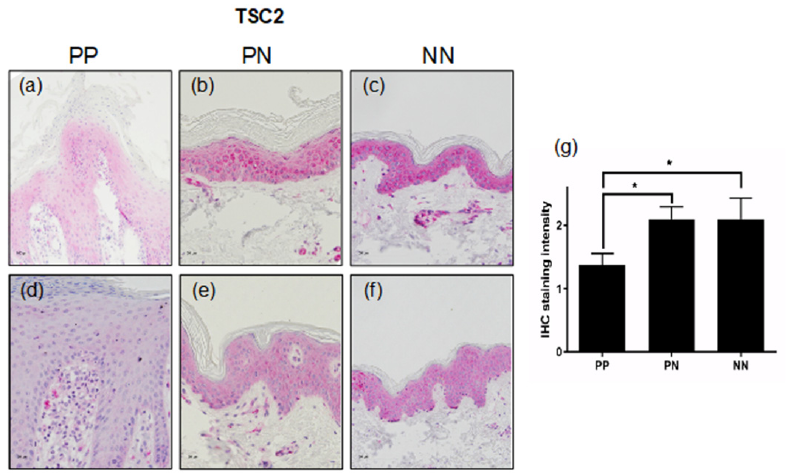
Figure 2. ( a – f ) IHC staining with P-TSC2-S939-specific antibodies of two representative biopsies from lesional (PP; a , d ) or non-lesional (PN; b , e ) skin of psoriasis vulgaris patients or healthy donors (NN; c , f ). Bars represent 50 μ m. ( g ) The graph represents quantification of IHC staining intensities from 10 psoriasis patients and 3 healthy individuals (mean ± SEM).